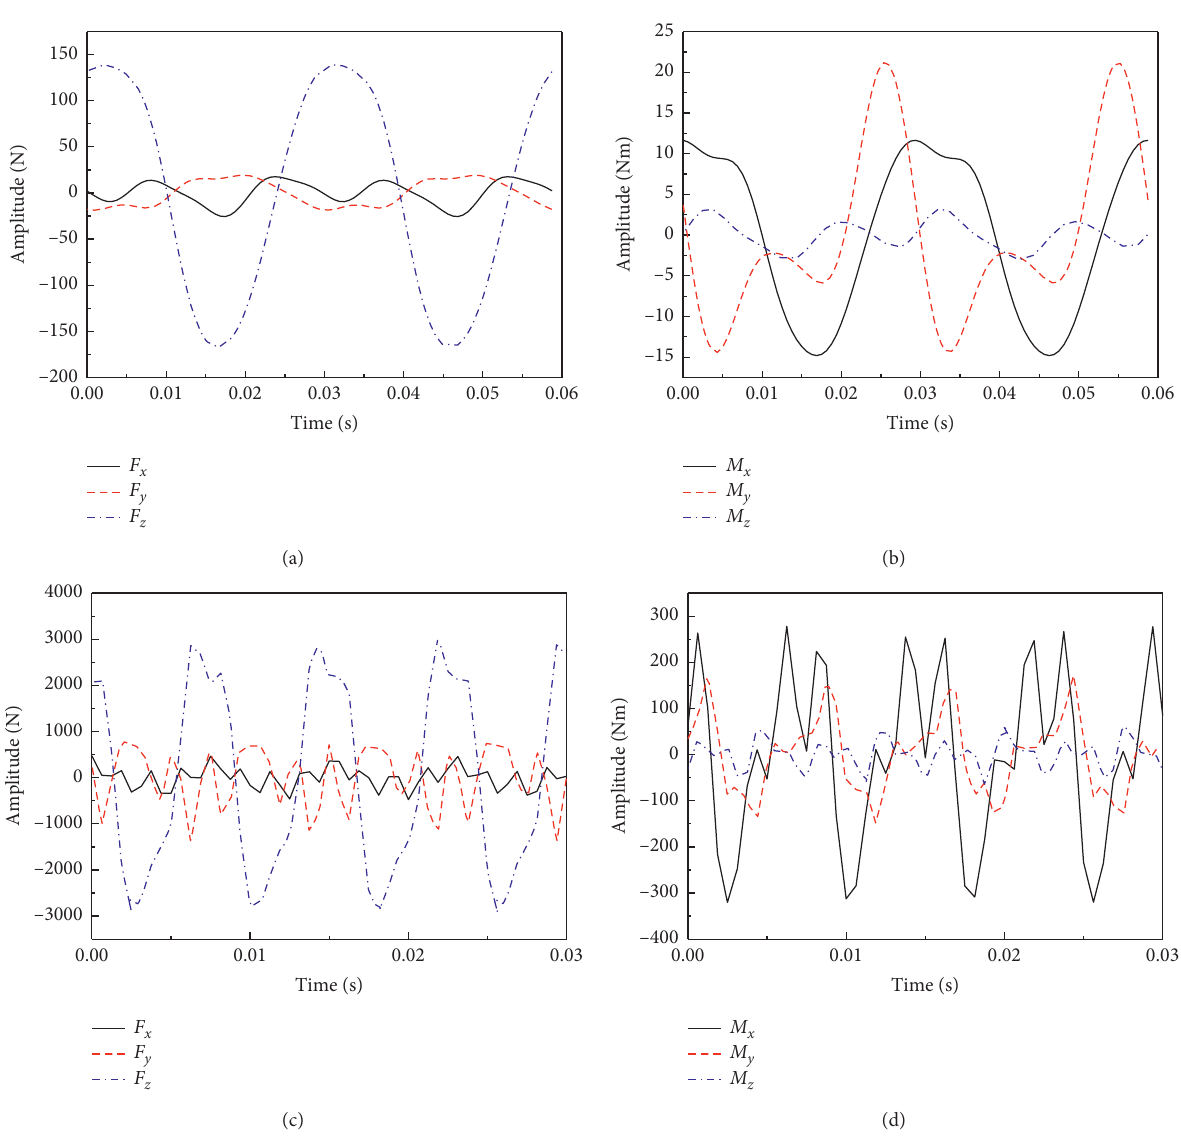
Figure 7: Excitation forces at the center of mass of powertrain identified under stable rotational speed (in the PCS). (a). Excitation forces in the time domain (1000rpm). (b). Excitation moments in the time domain (1000rpm). (c) Excitation forces in the time domain (4000 rpm). (d) Excitation moments in the time domain (4000